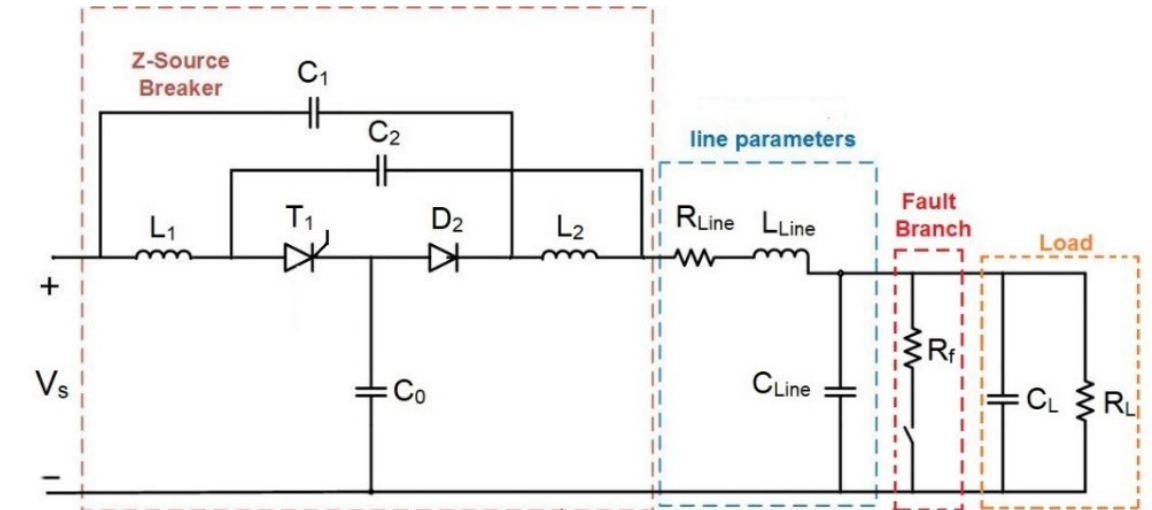
Figure 1. Physical models of Inter-Cross-Connected Bi-directional Z-source Circuit Breaker (ICC-BZCB), cable line, load, fault branch, and their